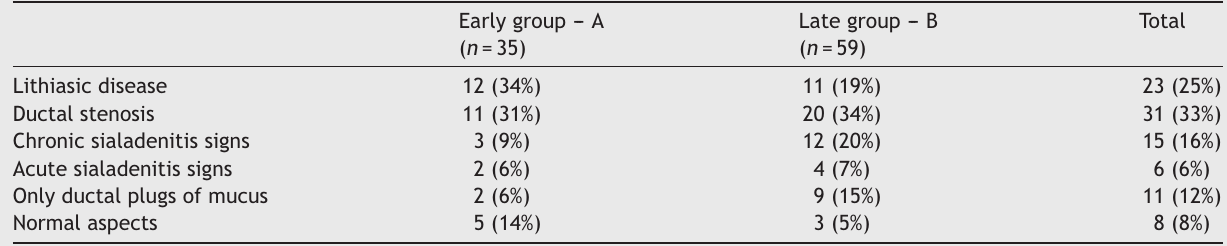
Table 3 Endoscopic findings in early and late groups of sialendoscopy experience (excluded cases with failure to complete